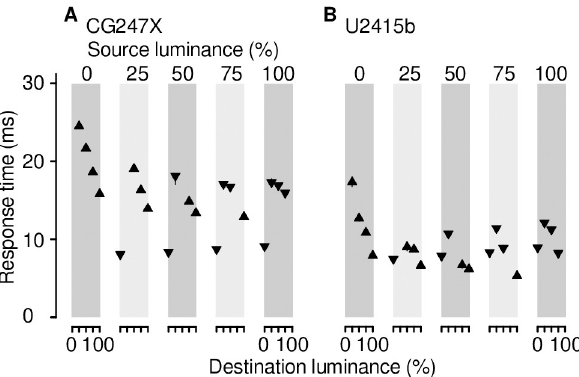
Fig 5. Response times. ( A ) CG247X response times. The leftmost gray box (labelled “0%”) encompasses four points showing mean response times for transitions from source luminance = 0% to destination luminances = 25, 50, 75, and 100% (x axis). These rise times (upward triangles) decreased with increasing destination luminance. The gray box labelled “25%” shows mean response times of transitions from source luminance = 25% to destination luminances = 0, 50, 75, and 100%. The fall time (downward triangle), from 25% to 0% luminance, was less than the rise times. Overall, response times varied as a function of both source and destination luminance, as is generally expected of LCDs. We made 10 measurements at each source/destination luminance pair; error bars, where not obscured by symbols, mark the full range (from minimum to maximum) of these 10 measurements. ( B ) U2415b response times. Graphical conventions are as in A. Overall, U2415b response times were less than CG247X response times.